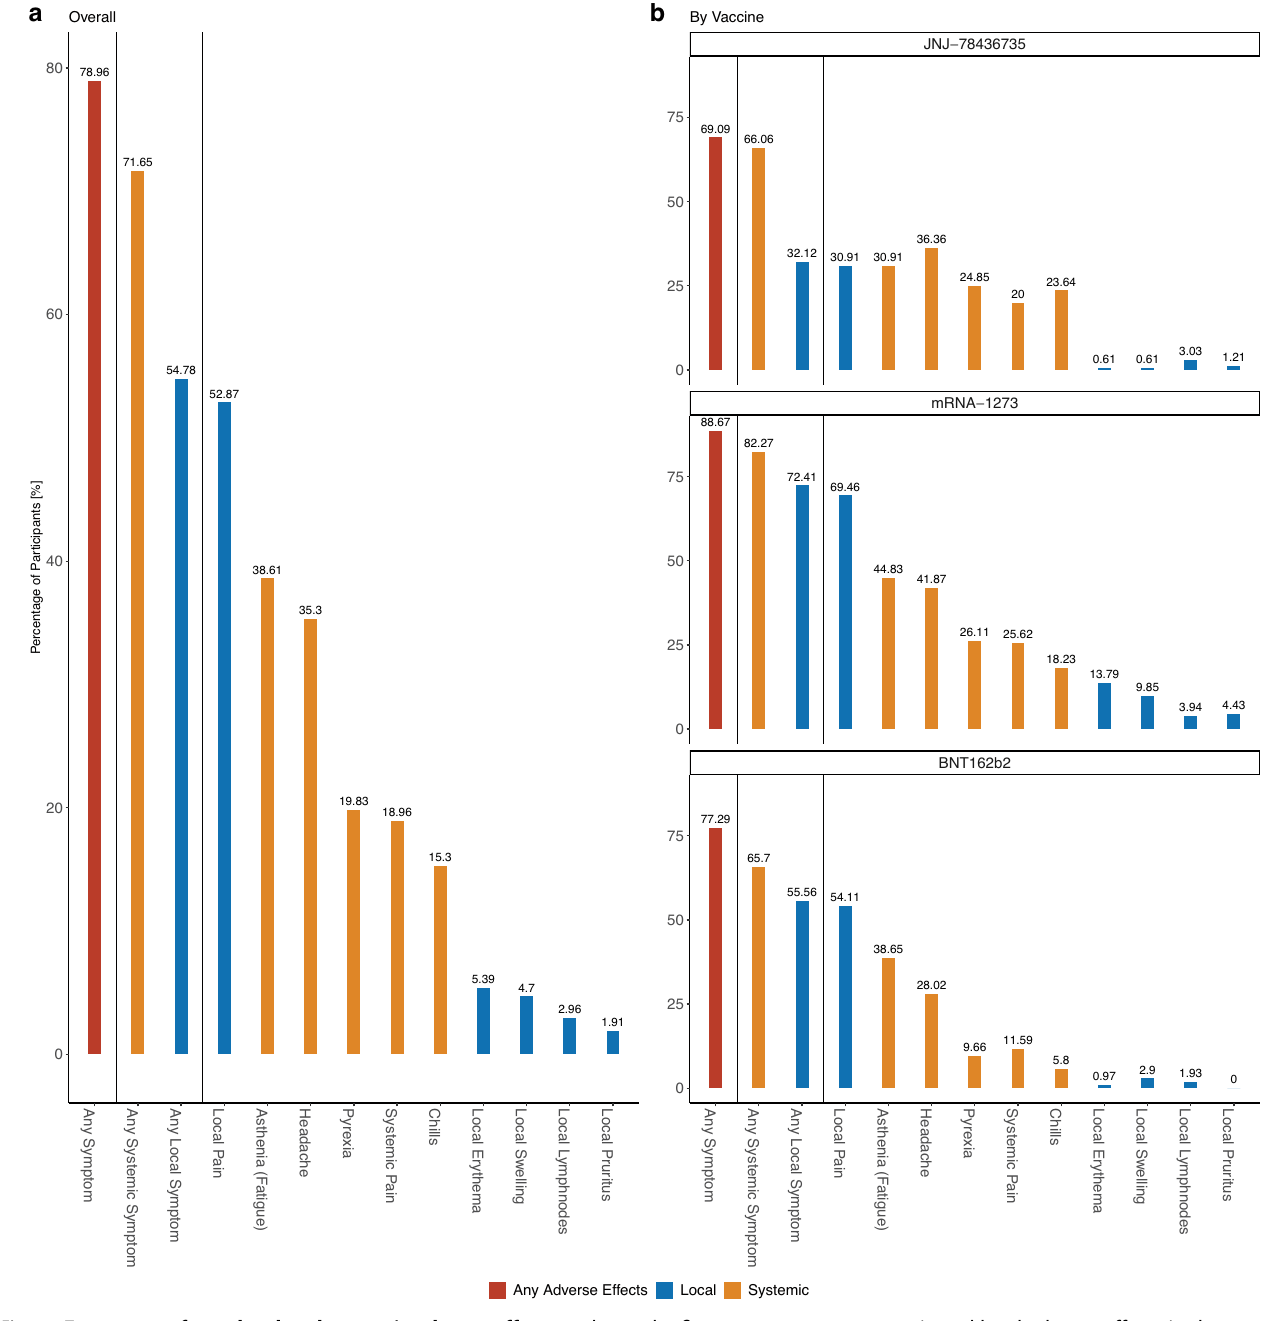
Fig. 1 Frequency of any, local and systemic adverse effects. a shows the fi ve most common systemic and local adverse effects in the overall sample ( N = 575). b shows the most common adverse effects by vaccine type (BNT162b2 N = 208, mRNA-1273 N = 203, JNJ-78436735 N = increased after the 2 nd dose (63.9% to 77.2% in BNT162b2 and 59.1% to 78.0% in mRNA-1273 recipients, Supplementary Table 4). The most common adverse effect mentioned by mRNA vaccine recipients was local pain (54.1% of BNT162b2 and 69.5% of mRNA- 1273 recipients), followed by asthenia (fatigue; 38.7% of BNT162b2 and 44.8% of mRNA-1273 recipients) (Fig. 1b). JNJ-78436735 recipients most frequently reported headache (36.4%), followed by local pain (30.9%) and asthenia (30.9%) (Fig. 1b). Other commonly reported adverse effects included nausea, vertigo, and sore throat (all >5%). Of all participants, 0.4% ( n = 2; one